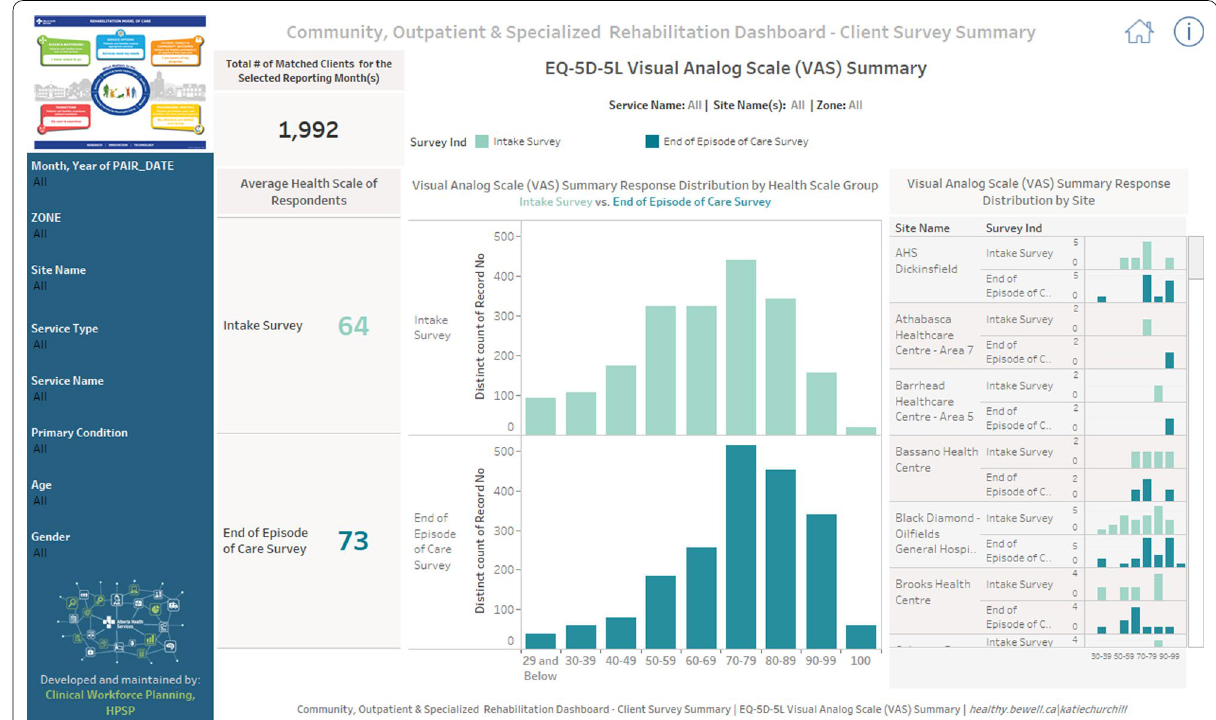
Fig. 1 AHS Tableau Dashboard for Community Rehabilitation—Visual Analogue Summary view. In this figure, the EQ VAS score for 1992 patients with complete data at intake and end of episode of care is presented; mean of 64 at intake, and 73 at the endof episode of care. The distribution of scores at both time points is also presented. The summary also showcases (right) the distribution of scores by